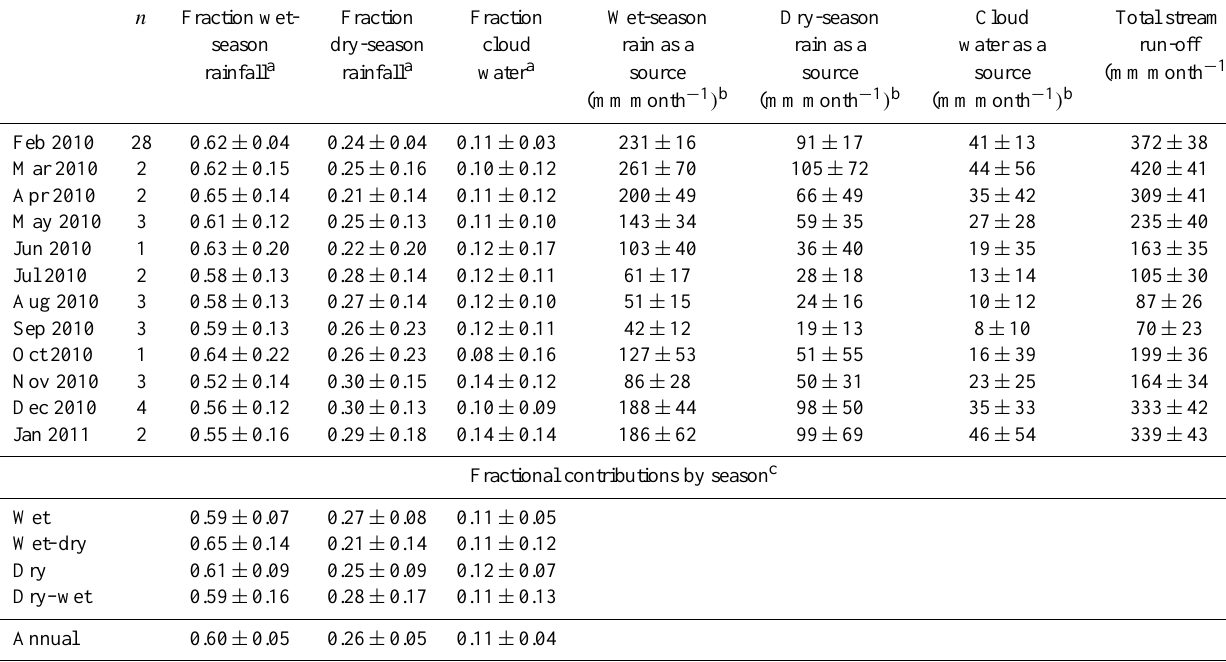
Table 3. Breakdown of streamflow into its